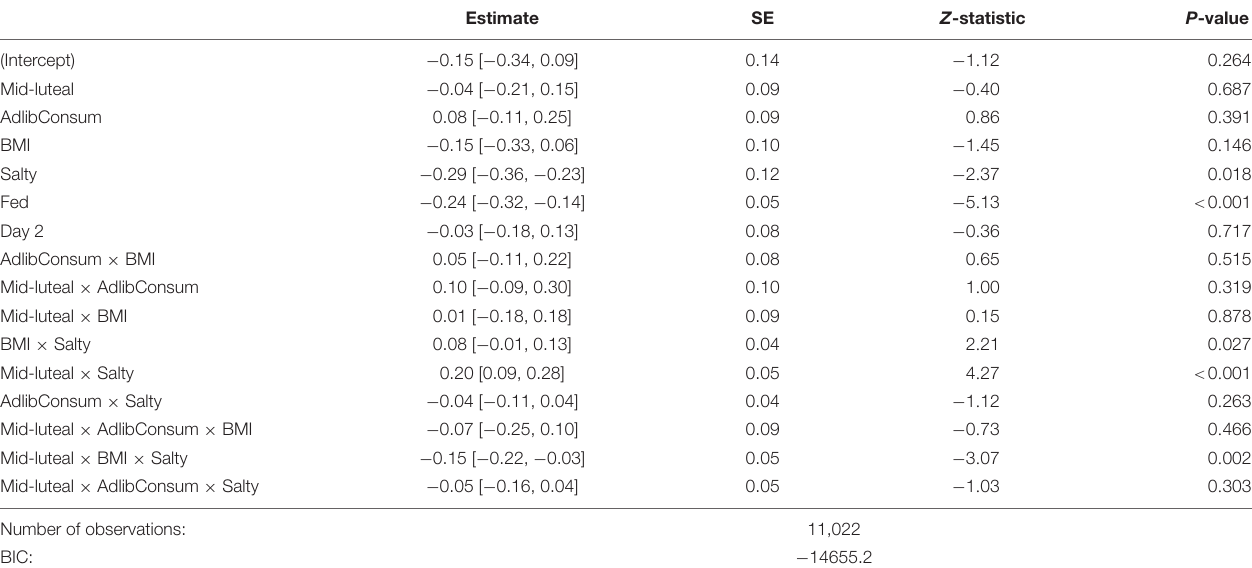
TABLE 2 | The generalized linear mixed model (GLMM) reveals a main effect of satiety state, an interaction of cycle phase with snack taste, and a three-way interaction of cycle phase with snack taste and BMI to significantly predict WTP conv . Estimate SE Z